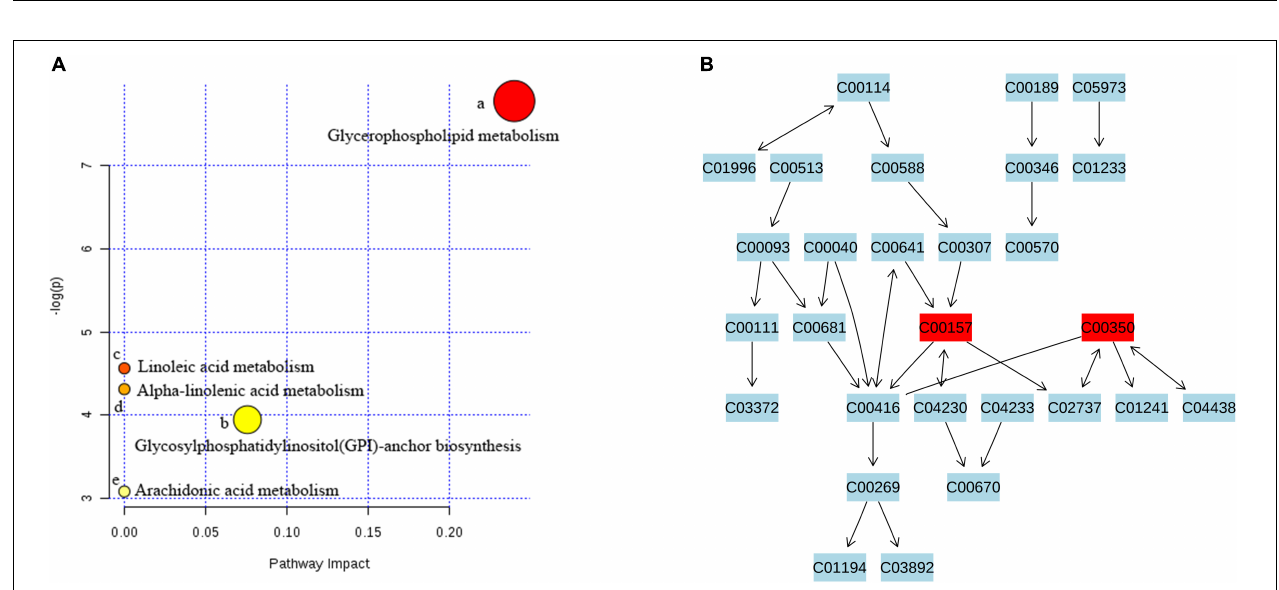
FIGURE 7 | Metabolic pathway analysis and visualization of Huanglian Jiedu decoction (HLJDD) treatment. (A) Summary of metabolomics pathway analysis based on the KEGG database. All matched pathways are presented as circles, including glycerophospholipid metabolism (a); glycosylphosphatidylinositol (GPI)-anchor biosynthesis (b); linoleic acid metabolism (c); alpha-linolenic acid metabolism (d); and arachidonic acid (AA) metabolism (e) from significantly differential lipids. The color and size of each circle are based on P -value and pathway impact value, respectively. (B) Pathway of glycerophospholipid metabolism with metabolomics pathway analysis based on the KEGG database. The matched metabolite numbers are consistent with the KEGG database.